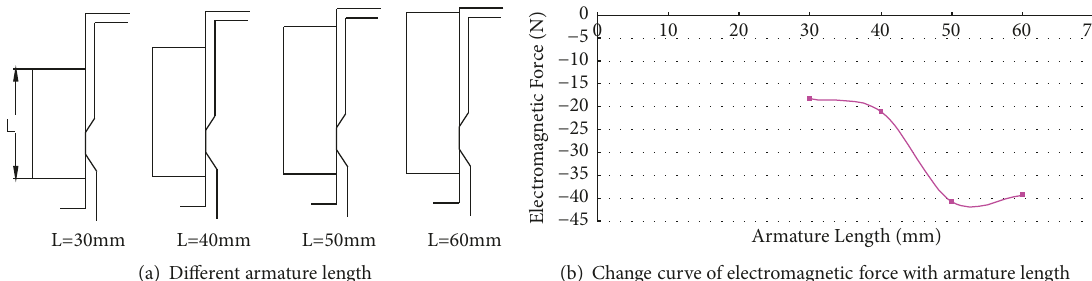
(b) Change curve of electromagnetic force with armature length Figure 6: Different armature lengths and their effect on electromagnet force.